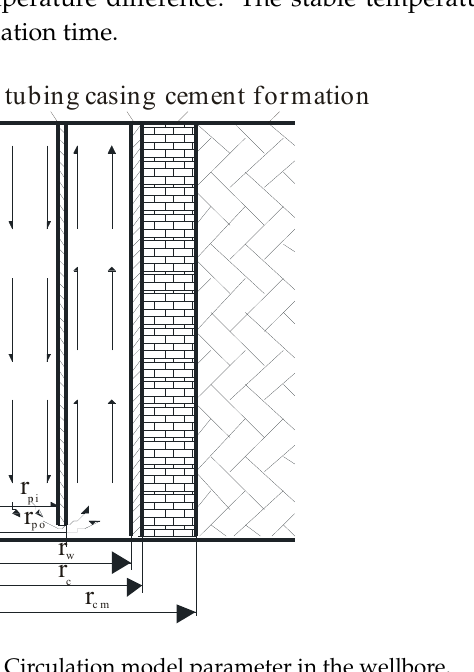
Figure 1. Circulation model parameter in the wellbore.